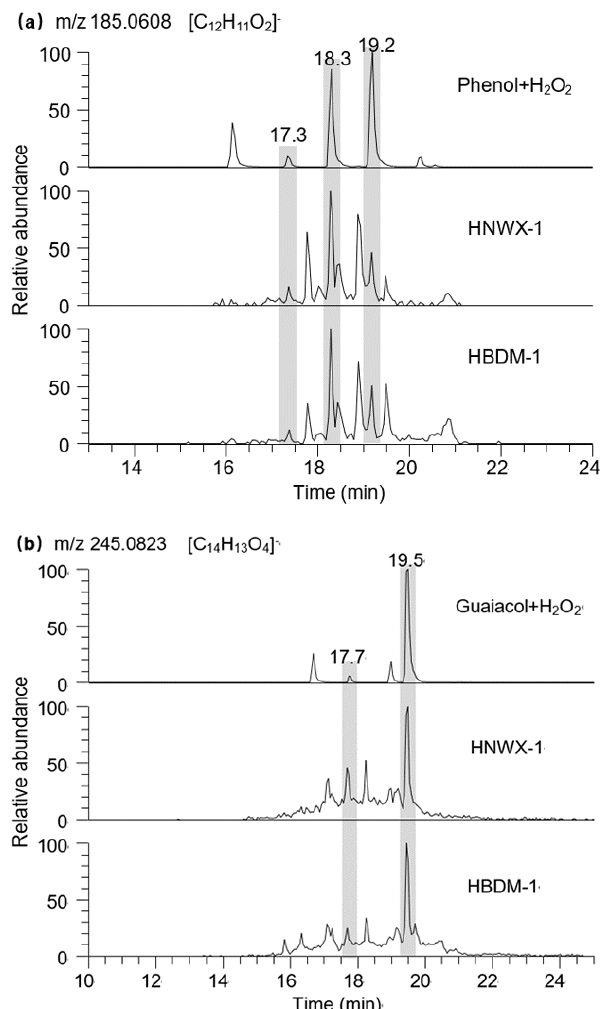
Figure 4. Extracted LC chromatograms of (a) m/z 185.0608 and (b) m/z 245.0823 in photochemical samples of phenols, HNWX-1, and